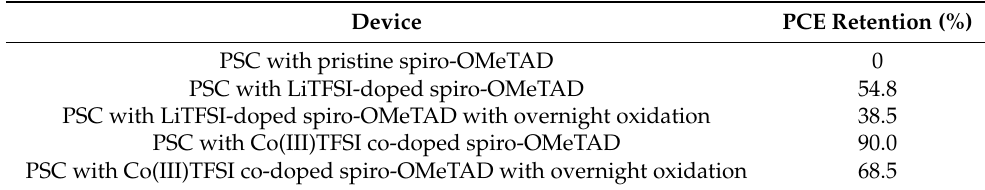
Table 3. Stability analysis for the unencapsulated perovskite solar cells. The power conversion efficiency (PCE) of perovskite solar cells with LiTFSI-doped spiro-OMeTAD and Co(III)TFSI co-doped spiro-OMeTAD with and without